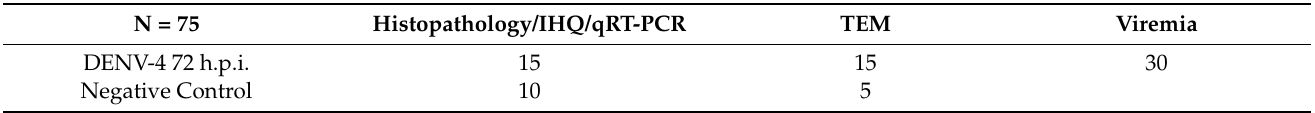
Table 1. Number of BALB/c used for histopathology, immunohistochemistry and molecular analysis, transmission electron microscopy, viremia analysis and negative control. N = 75 Histopathology/IHQ/qRT-PCR TEM Viremia DENV-4 72 h.p.i. 15 15 Negative